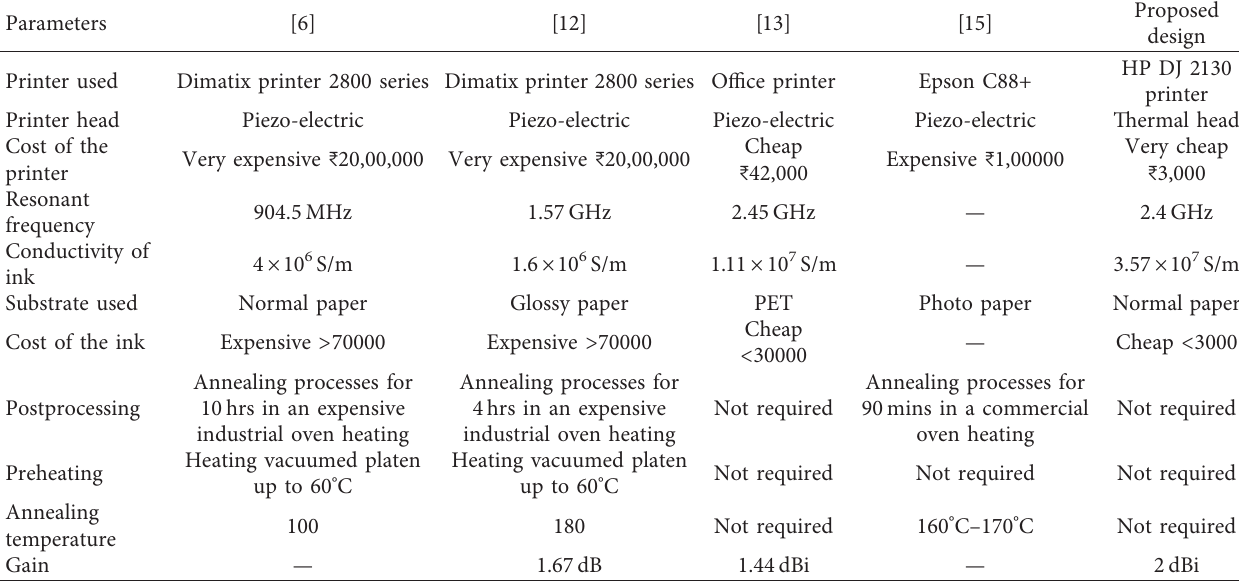
Table 3: Comparison of the proposed design and the recent